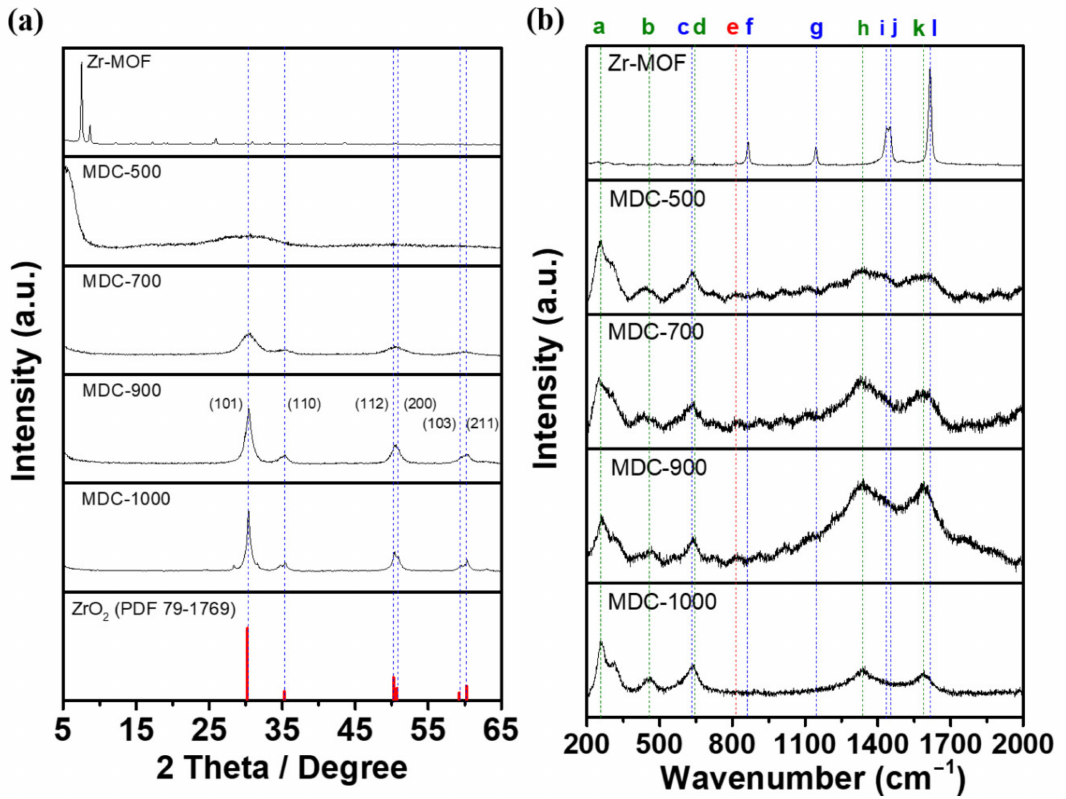
Figure 1. ( a ) XRD patterns and ( b ) Raman spectra of Zr-MOF, MDC-500, MDC-700, MDC-900, and